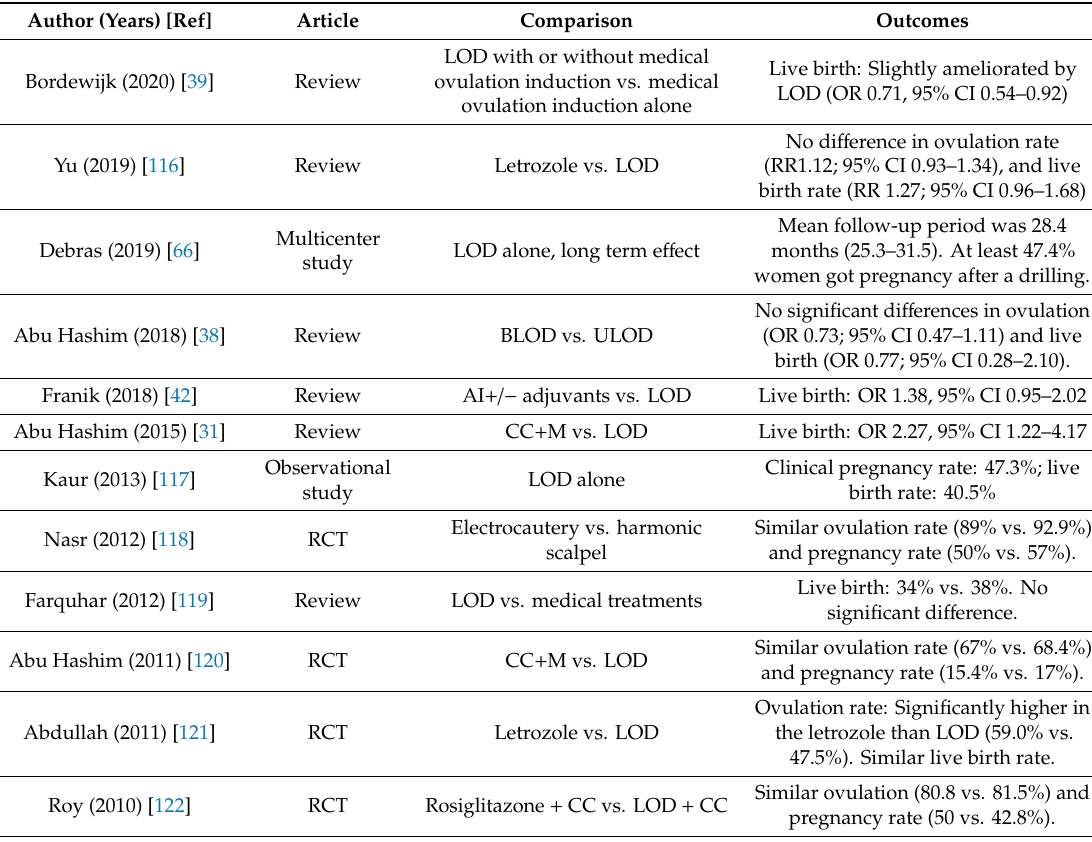
Table 1. A comparison of reproductive performance in women with clomiphene citrate-resistant polycystic ovary syndrome treated with laparoscopic ovarian drilling and non-laparoscopic ovarian